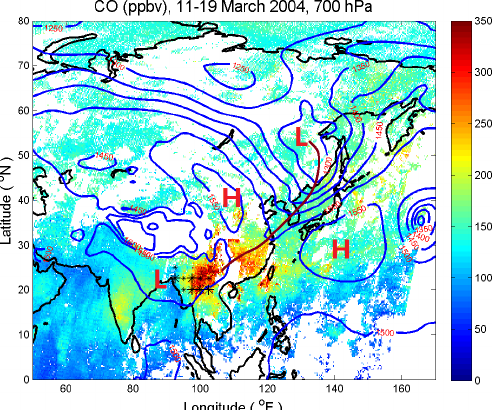
Figure 9. MOPITT CO mixing ratio at 700hPa from 11 to 19 March 2004, overlaid with the geopotential height at 850hPa on 17 March 2004 in blue contour and with a front shown by a brown solid line. The large and small stars denote daily mean fire counts of 100–200 and over 200 per 2.5 ◦ × 2.5 ◦ grid area during the period, respec- tively. L and H indicate a low and high pressure system, respec- tively.